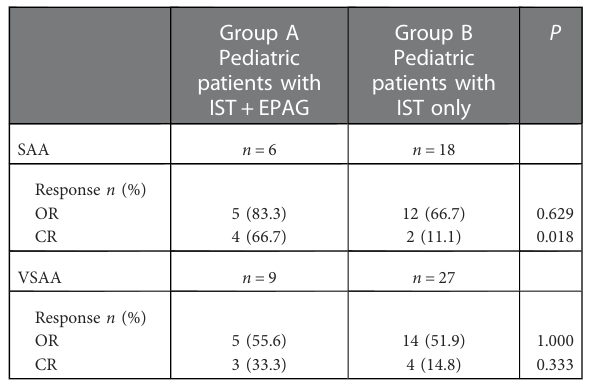
TABLE 4 Response at 6 months in SAA vs. VSAA.